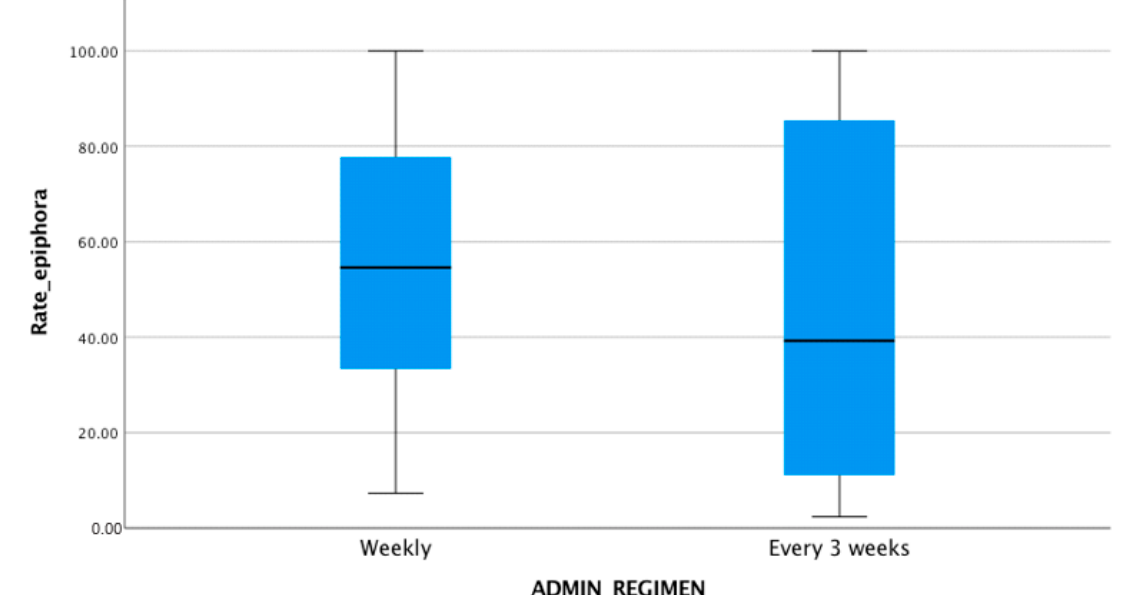
Figure 2. Rate of epiphora recorded in each administration regimen used, as median (54.64 for weekly regimen and 39.28 for every 3 weeks administration), maximum, and minimum values.